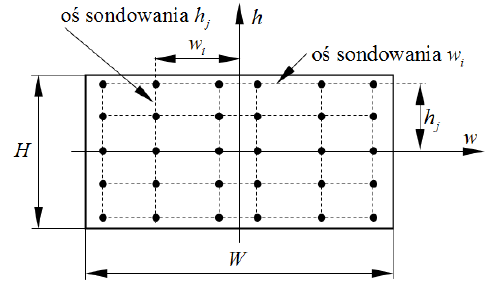
Fig. 7. Example of the measurement points determined in a rectangular cross-section Table 1. Location of measurement points in a